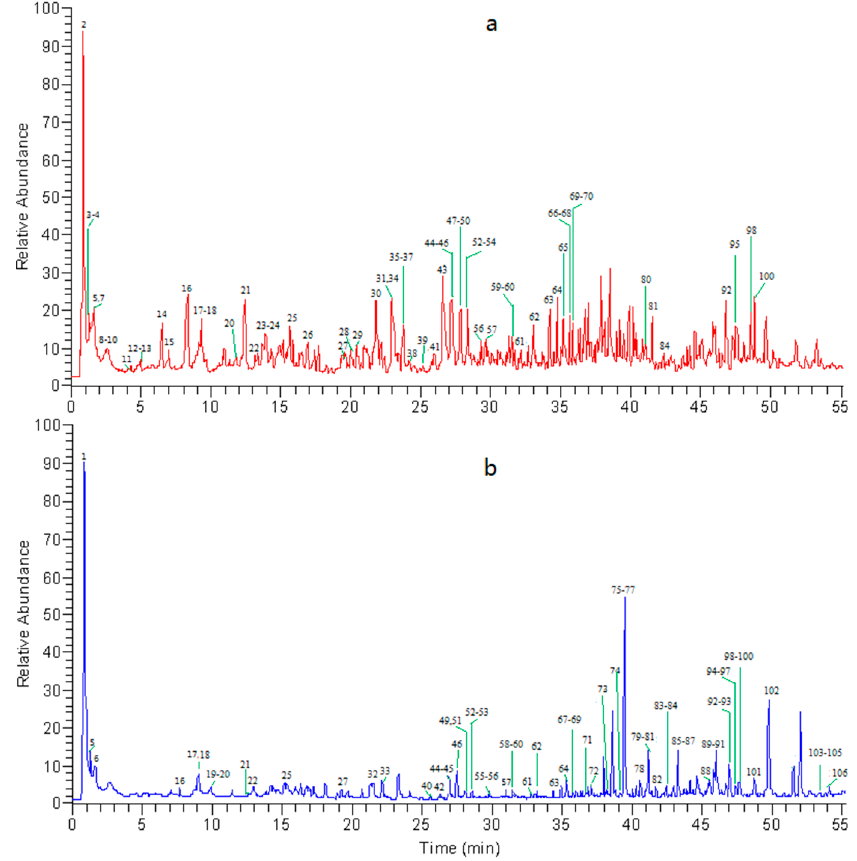
Figure 1. Total ion chromatogram (TIC) of WZYZW in negative ion mode ( a ) and positive ion mode ( b ) using UPLC-ESI-LTQ-Orbitrap-MS.